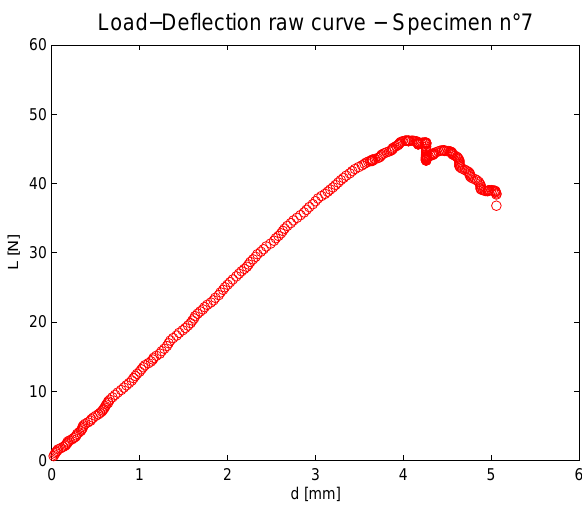
Figure 7: Raw load-deflection curve for specimen 7.